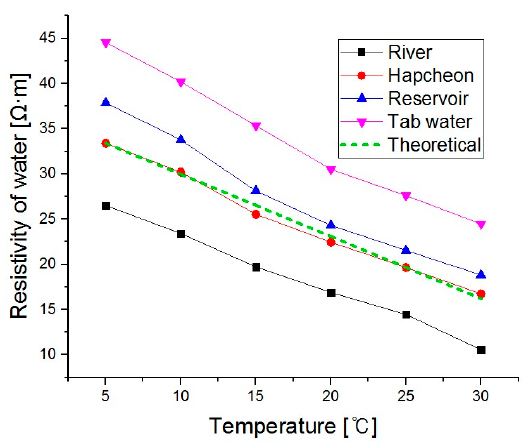
Figure 4. Resistivity of water from various sources against temperature.